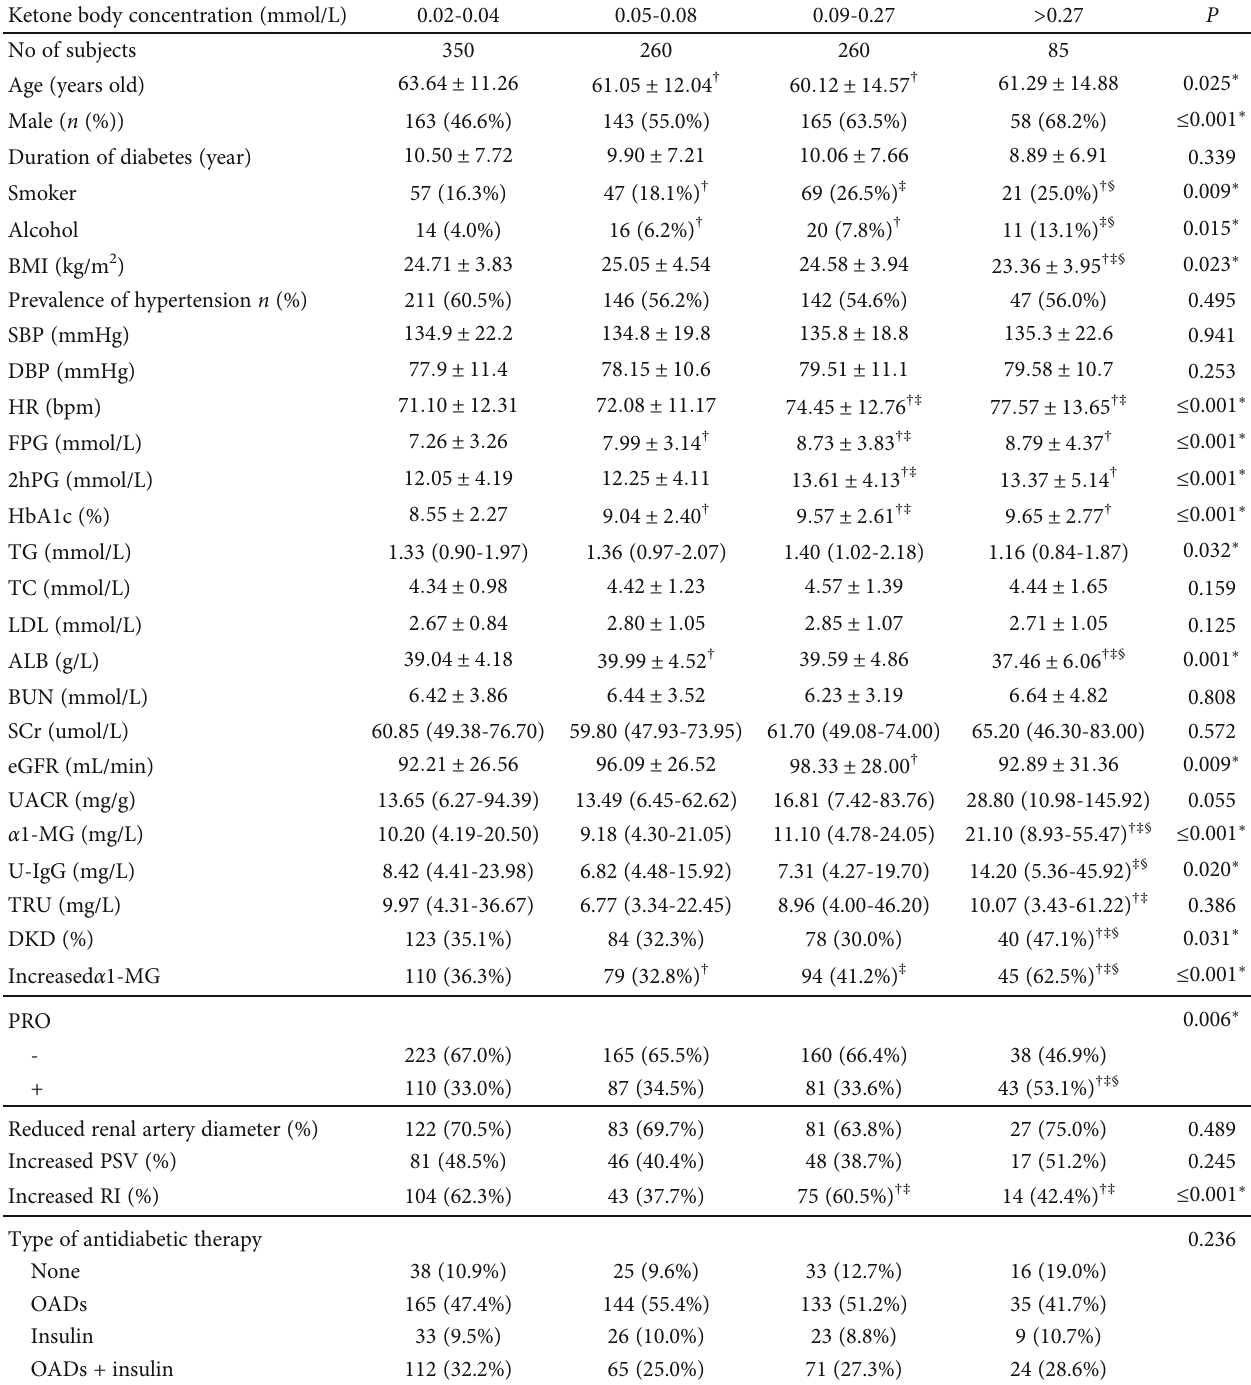
Table 1: The 955 T2DM patients ’ clinicopathological characteristics strati fi ed by serum ketone body